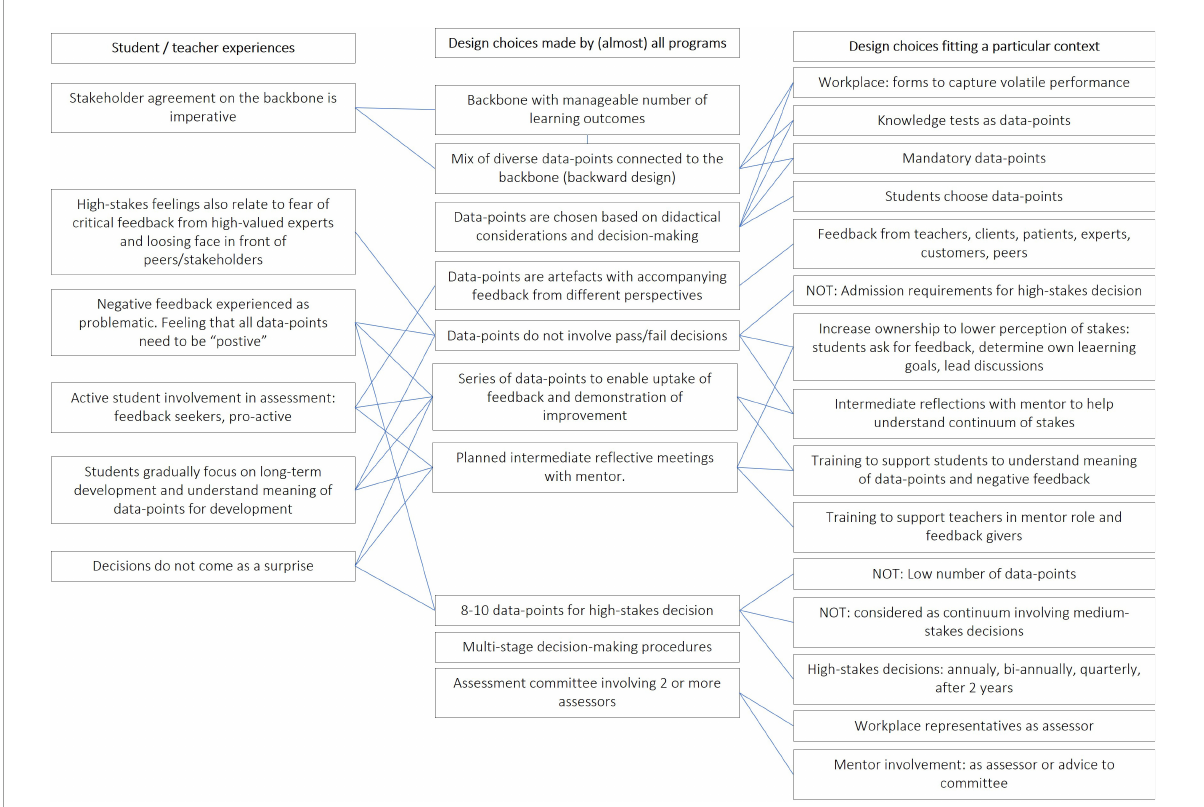
FIGURE1 Overview of design choices made by (almost) all programs, specific design choices made in a local context, and student/teacher experiences.